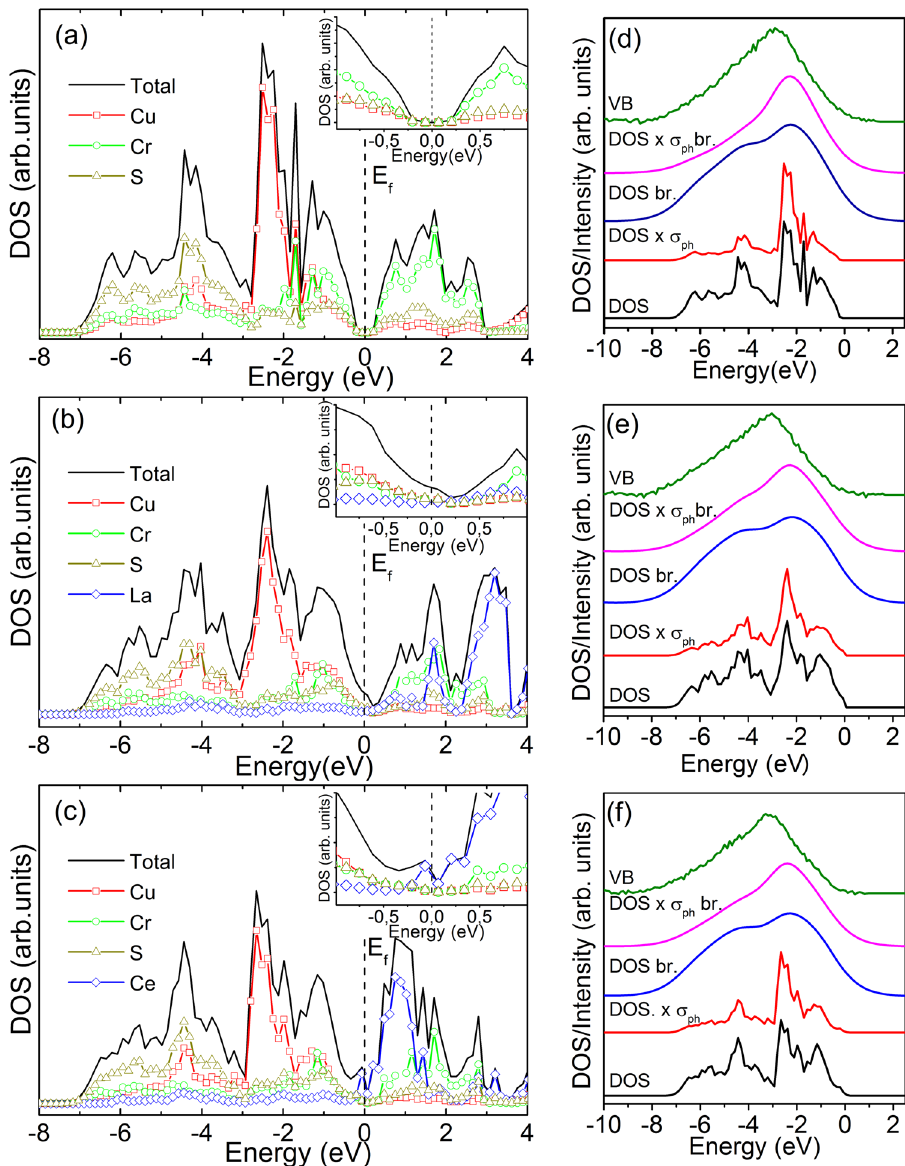
Figure 3. Theoretical total and partial DOS ( a – c ) for CuCrS 2 and CuCr 0.99 Ln 0.01 S 2 (Ln = La, Ce). Comparison of the experimental valence band (VB) spectra (green line) with theoretical DOS simulations ( d – f ) showing raw DOS simulations (black line); simulated DOS mathematically broadened for better consistency with the experimental VB (blue line); DOS scaled to the photoionization cross-sections of respective levels (red lines); DOS scaled to the photoionization cross-sections of respective levels; scaled and broadened DOS (magenta